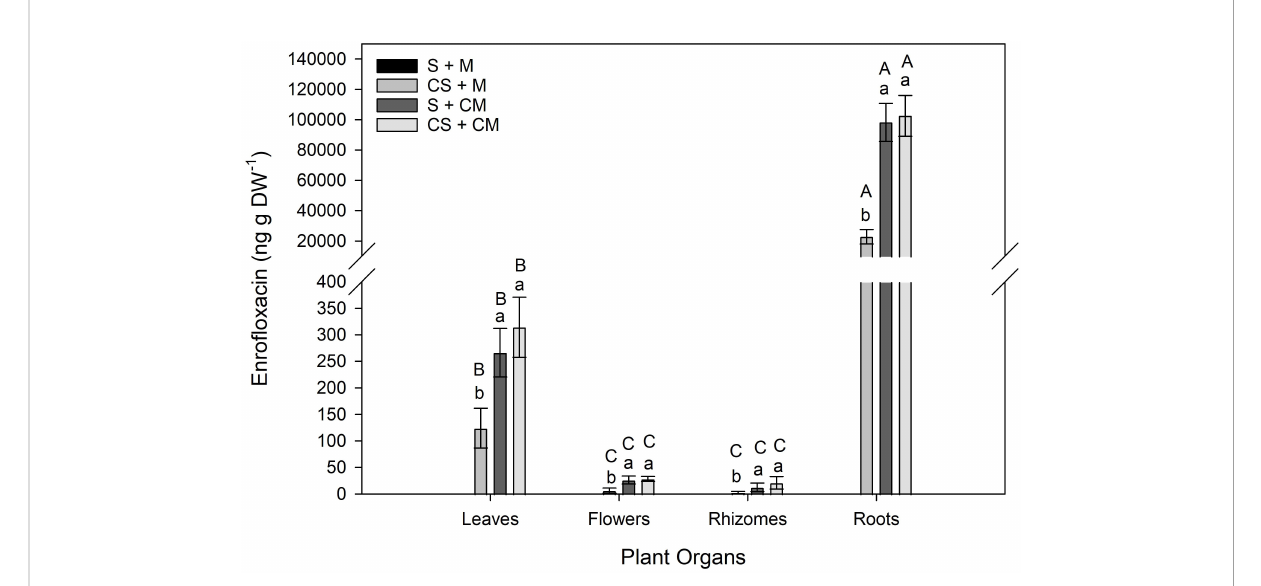
FIGURE 2 Enro fl oxacin concentration in different organs in calla lily plants grown in substrates with or without enro fl oxacin addition. Bars represent the means ± SD of fi ve replicates. Lower case letters indicate signi fi cant differences between treatments for the same plant organ; uppercase letters indicate